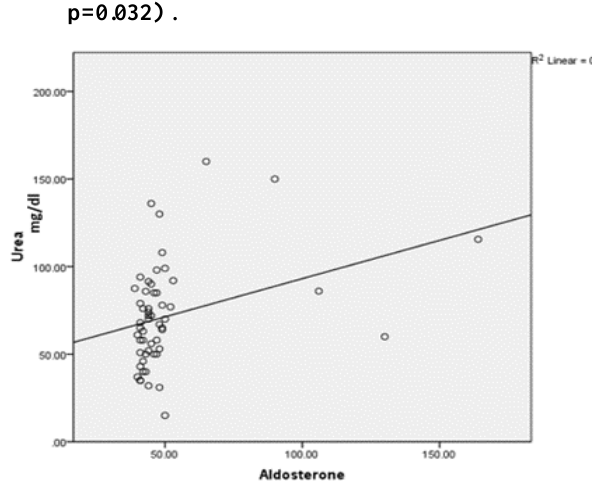
Figure 5. Correlation between Serum FGF- 23 and phosphate levels in CKD Patients with or without CV events (r=0.313 , p=0.032) .